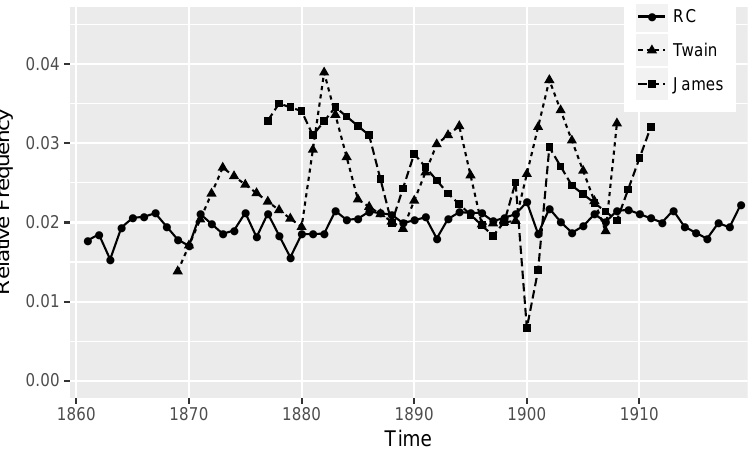
Figure 10: Male and female references for